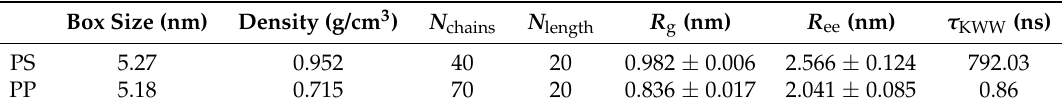
Table 1. Characteristic properties of the equilibrated systems at simulated temperature T = 500